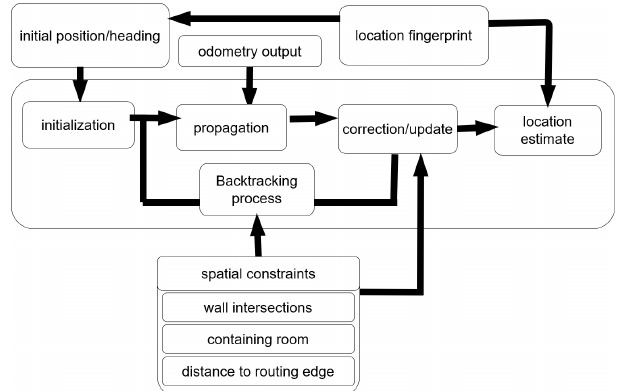
Figure 4. Overview of the particle filter algorithm. The initial position and heading, derived from the location fingerprint, is used for the initialization of the particles, which are then propagated according to the odometry output. The particles are then filtered in the correction/update according to spatial constraints, leading to a final location estimation, which is further improved by the location fingerprint. Via the backtracking process, the number of valid particles is increased up to the original amount of particles by considering spatial constraints. Next, the next propagation step